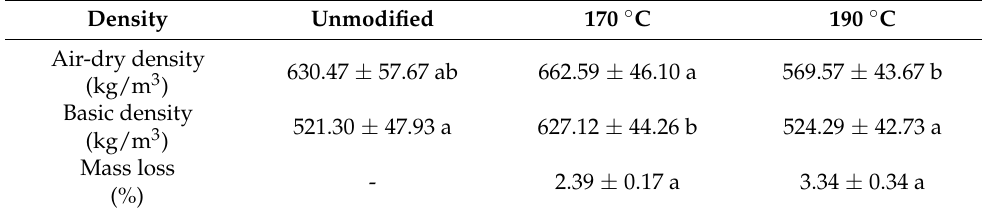
Table 1. Wood densities and mass loss of thermally modified Pinus oocarpa